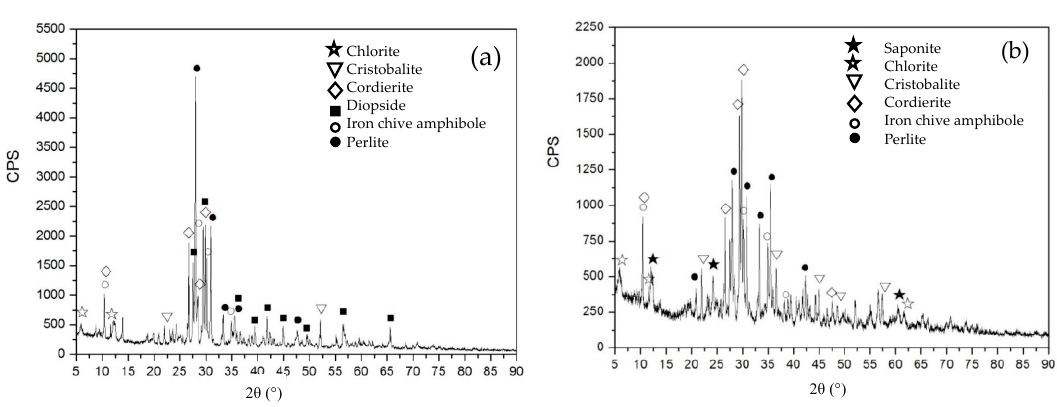
Figure 1. Results of X-ray diffraction (XRD) for coarse tailings and fine tailings: ( a ) coarse tailings; ( b ) fine tailings. Figure 2. The particle size distribution of fine tailings and coarse tailings. Table 1. Mineralogical composition of coarse tailings.